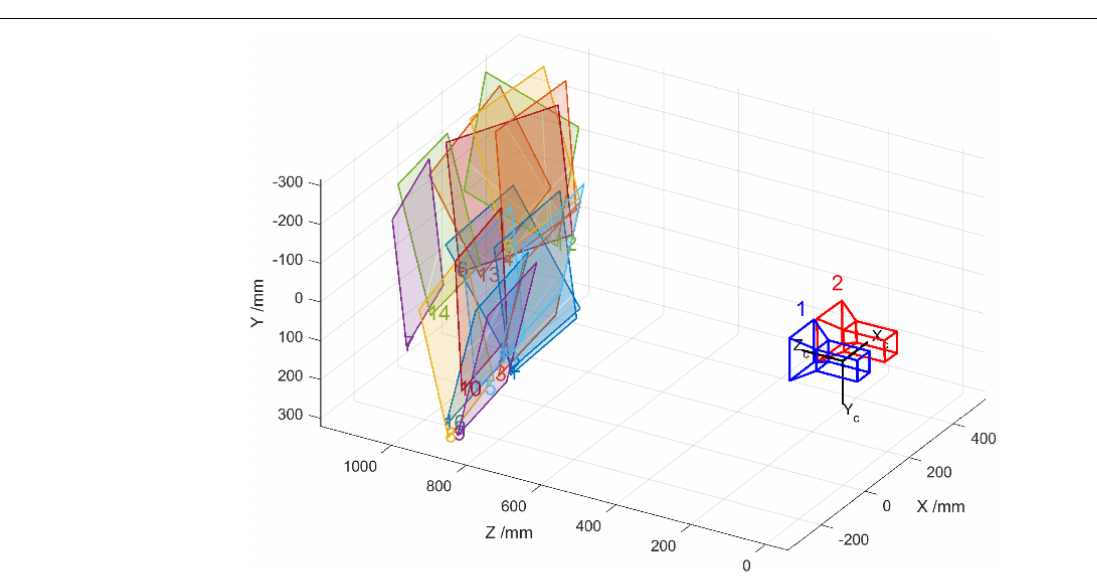
FIGURE 14 | Binocular calibration errors of each image pairs.